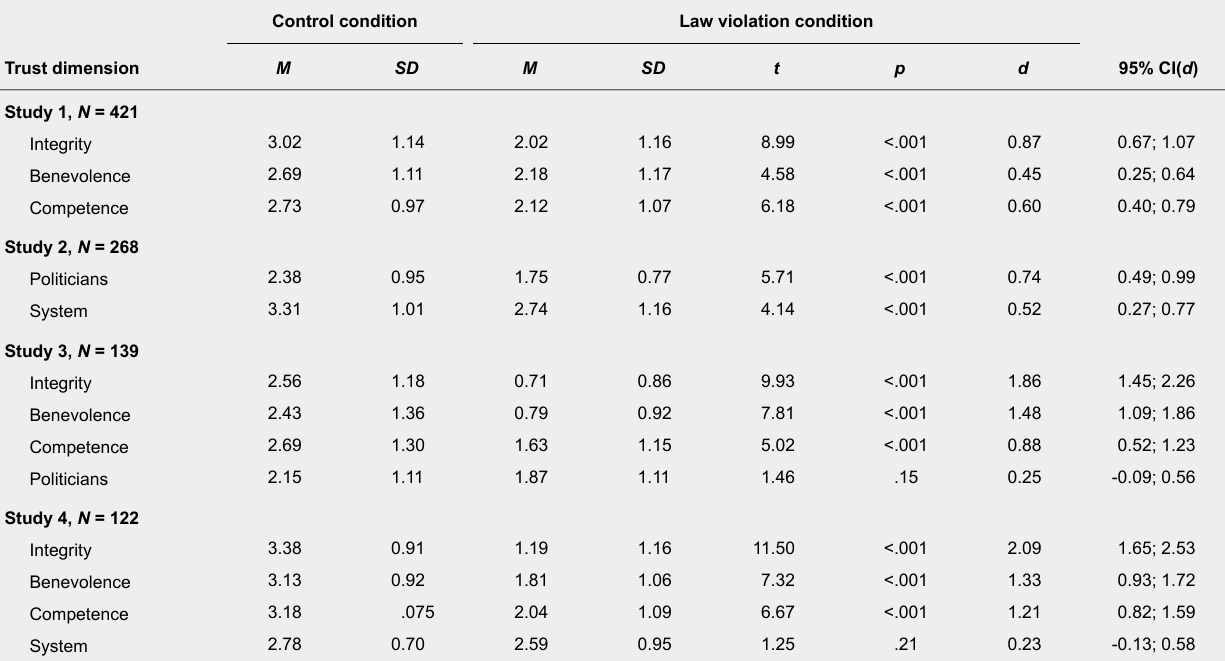
Means and Standard Deviations for Trustworthiness Evaluations Presented Separately for Experimental Conditions in Studies 1 to 4